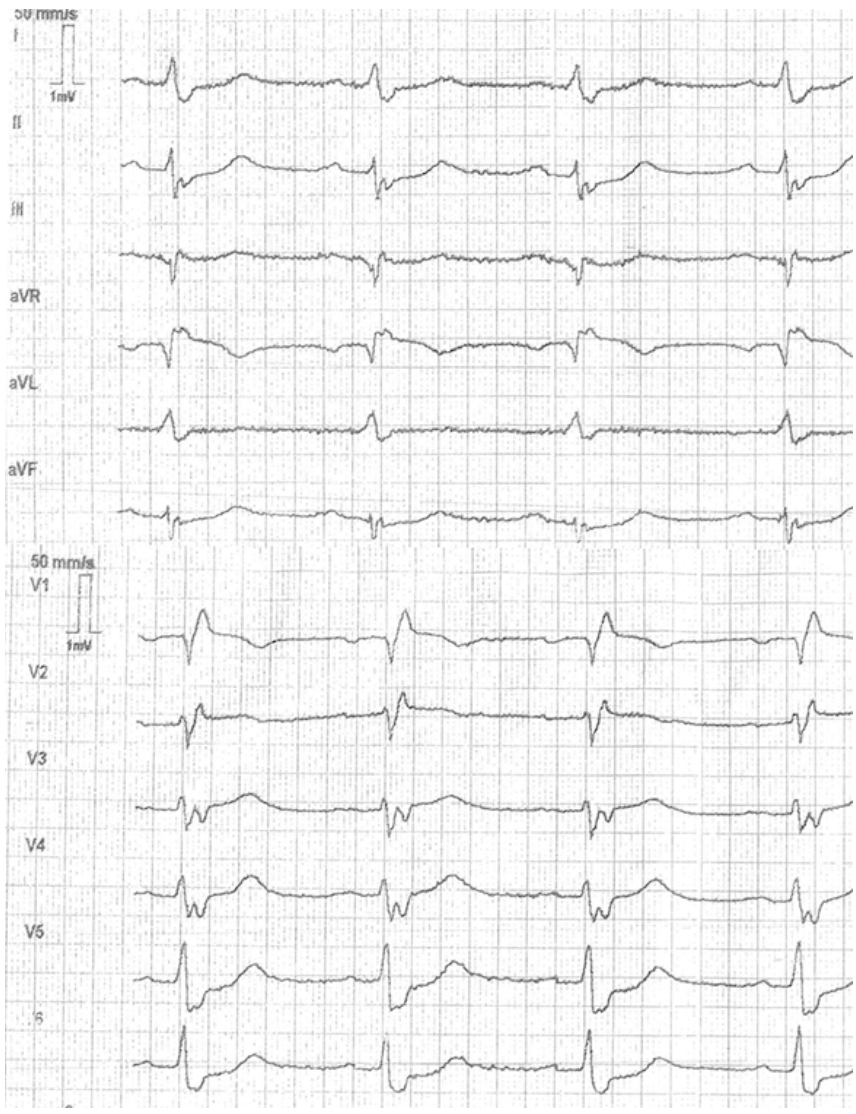
Figure 1. A 12 ‐ lead surface ECG showing ST segment elevations in aVR, V1 and V2. A relevant coronary artery disease was ruled out. The patient’s shock was aggravated with an elevated arterial lactate of 3.5 mmol/L, requiring an inotropic therapy (Table 1) and volume substitution (400 mL/h) to maintain a mean blood pressure of 60–70 mmHg. Due to the findings of the TTE showing primarily a right heart enlargement and impaired right ventricular function (Table 1, Figure 2), it was decided to perform an additional right heart catheterization with pulmonary angiography. A massive bilateral embolism was found (Figure 3), with a pulmonary artery pressure (PAP) of 44 mmHg systolic (sPAP), 23 mmHg diastolic (dPAP), and 29 mmHg mean (mPAP). On account of a